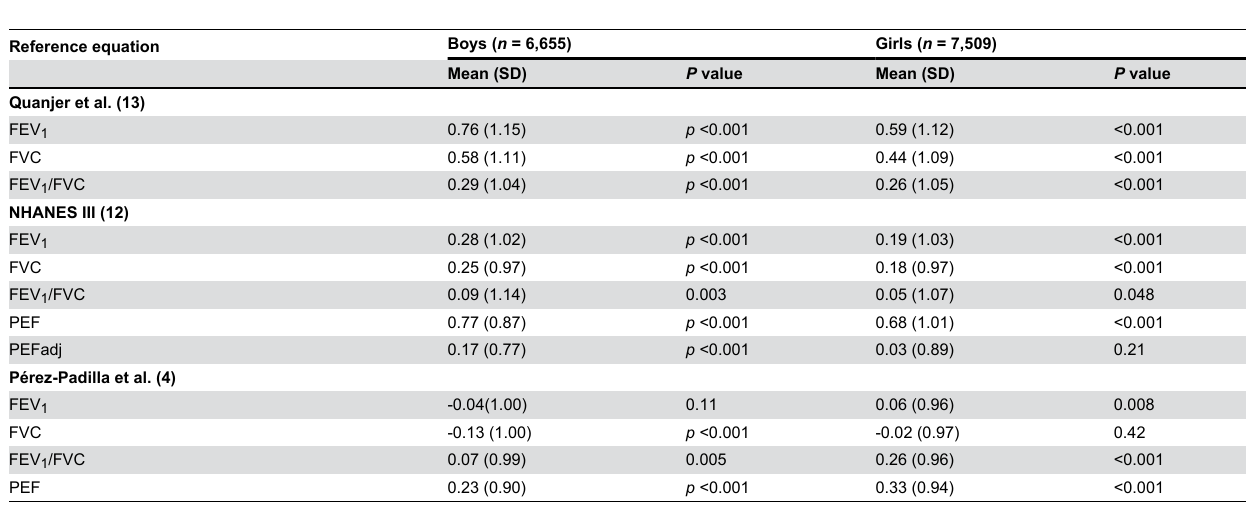
Table 3. Mean spirometric values of the studied population (average of all longitudinal observations) expressed as Standard deviations (SD) from three cross-sectional reference values.